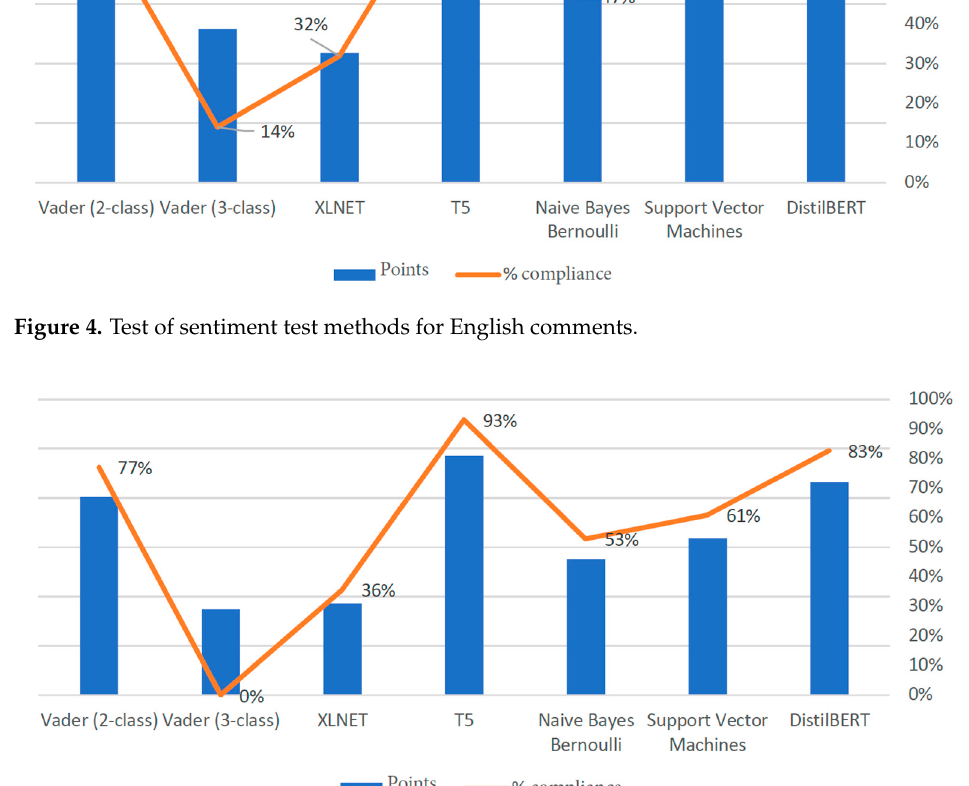
Figure 5. Test of sentiment test methods for English comments without those considered neutral.